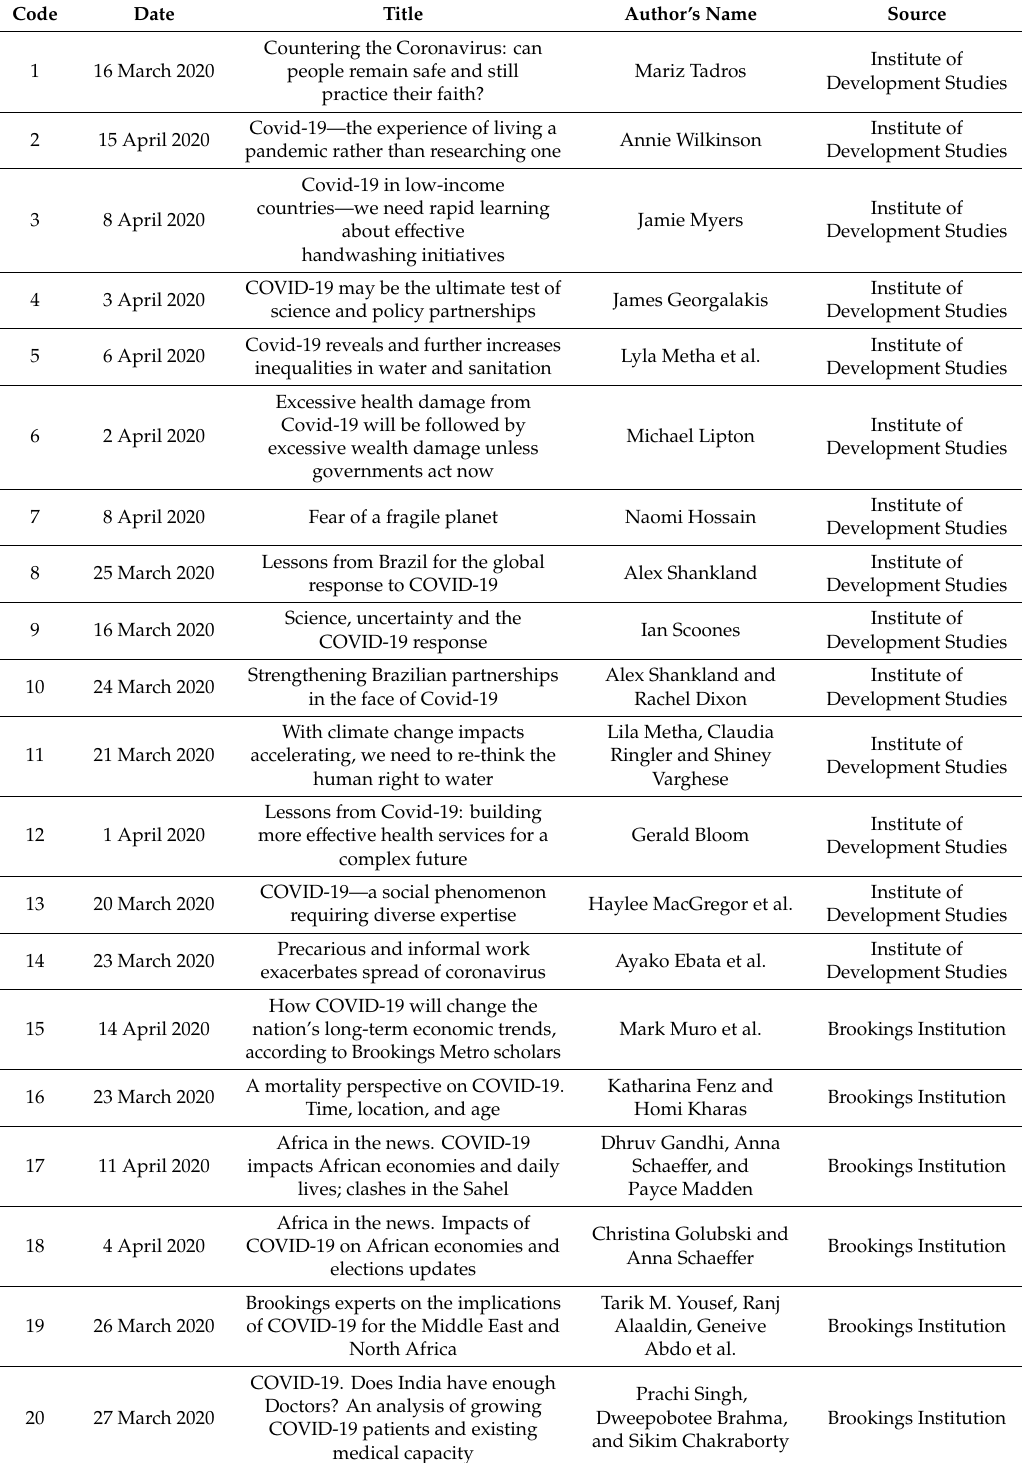
Table A1. Documents used for the analysis after